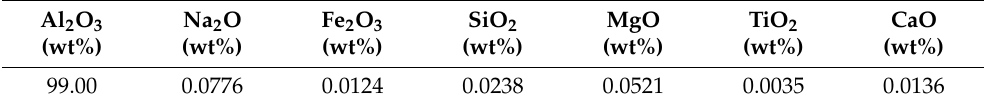
Table 1. Chemical component of Al 2 O 3 powder (wt%) as described by the